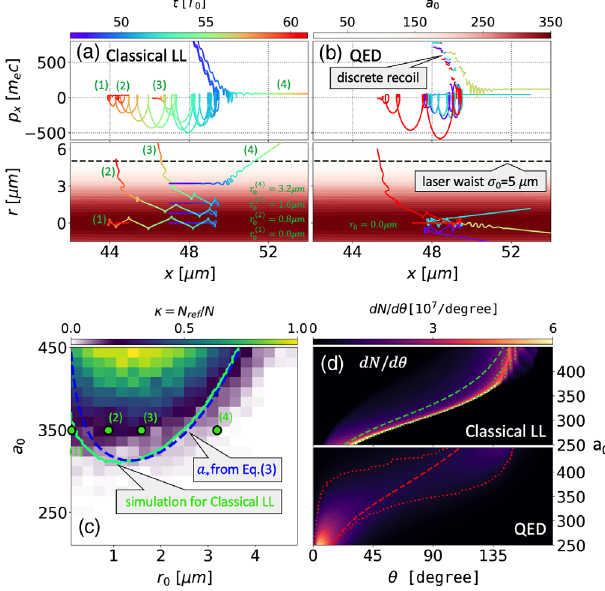
FIG. 2. (a) The evolution of p versus x and trajectories of four x electrons ( r 0 ¼ 0 . 0 , 0.8, 1.6, and 3 . 2 μ m, respectively) charac- terized by the classical LL for a 0 ¼ 350 , where the rainbow color scale denotes the time and the white and red color map corresponds to the strength of the laser field amplitude. (b) is the same as (a) but for the QED electrons with the identical r 0 ¼ 0 in different colors. (c) The green solid line denotes the a (cid:3) simulated from the classical LL model, the blue dashed line refers to theoretical a of Eq. (10), and the viridis color map exhibits the (cid:3) calculation of the QED model. (d) The electron angular distri- bution dN=d θ for 250 < a 0 < 450 . The dashed green (red) line ¯ θ denotes the average value versus a 0 for the LL (QED) case, while the dotted line denotes the position of the